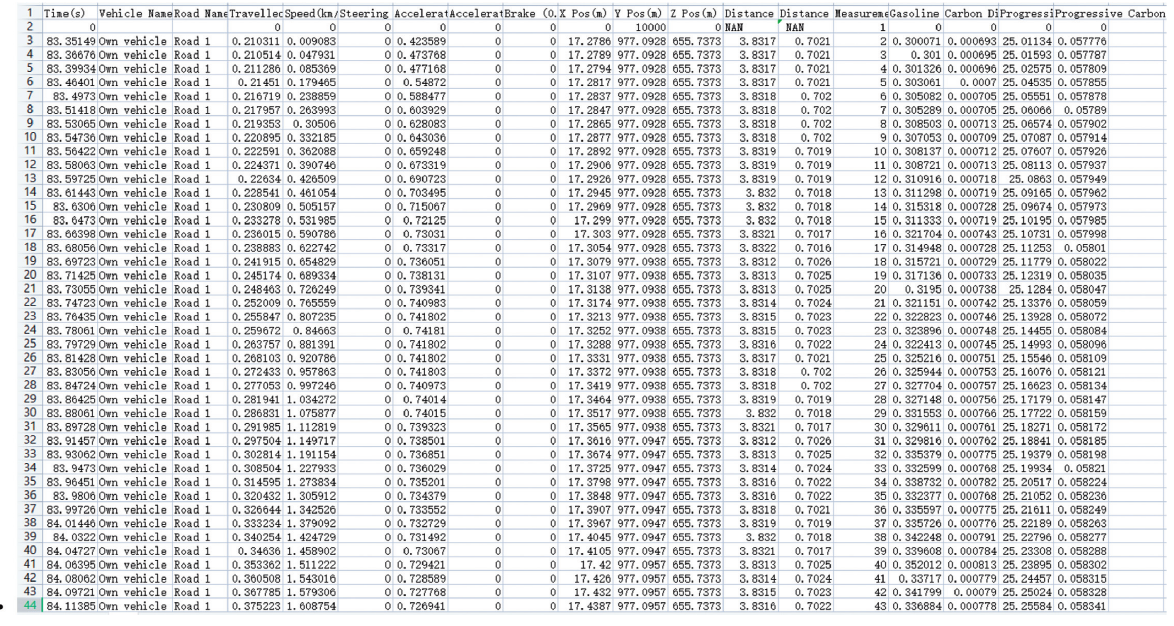
Figure 3: Export Table 4: Results of driving behavior indicators under various levels of roadside factors.